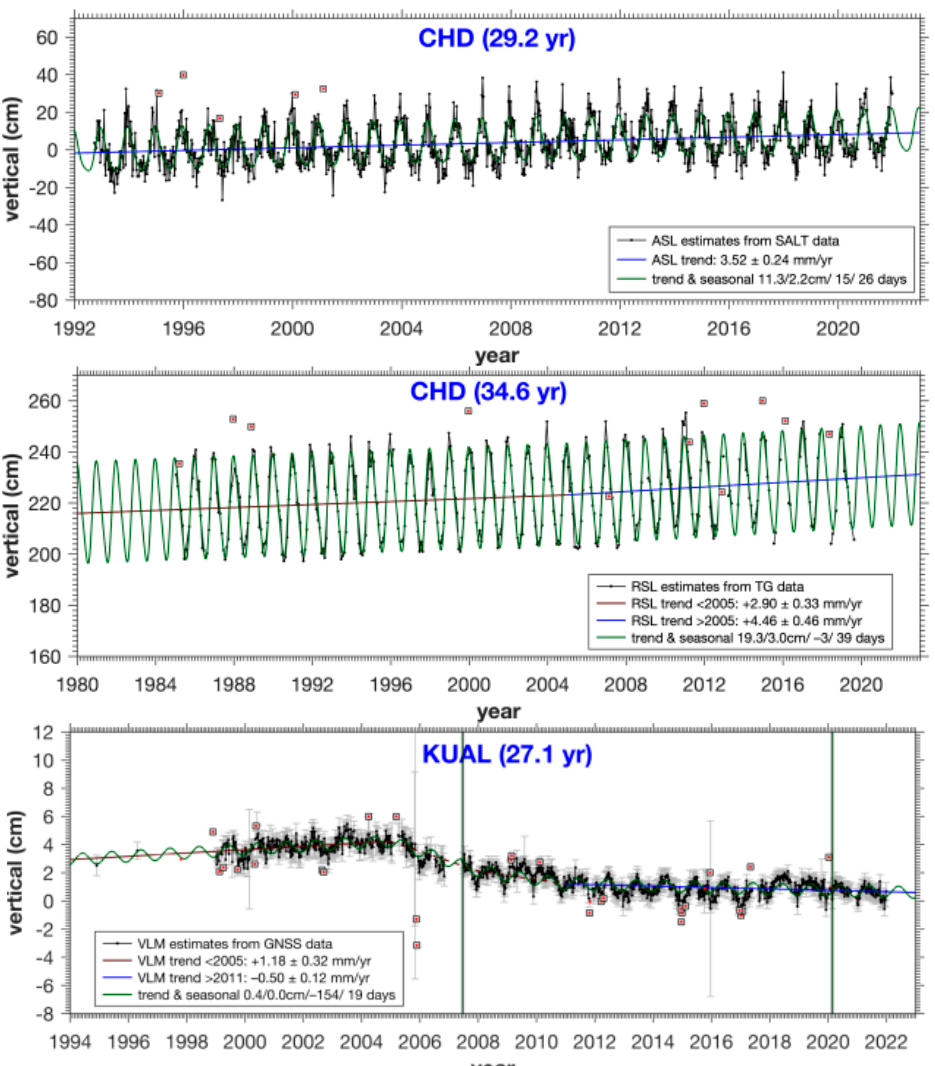
Figure 13. Relative sea level (from tide gauge), absolute sea level (from satellite altimetry), and vertical land motion (from GPS) trend estimates for tide-gauge station CHD and nearby GNSS station KUAL. The linear trend estimates from the tide gauges and GPS data have been split into two parts (<2005 and >2005).